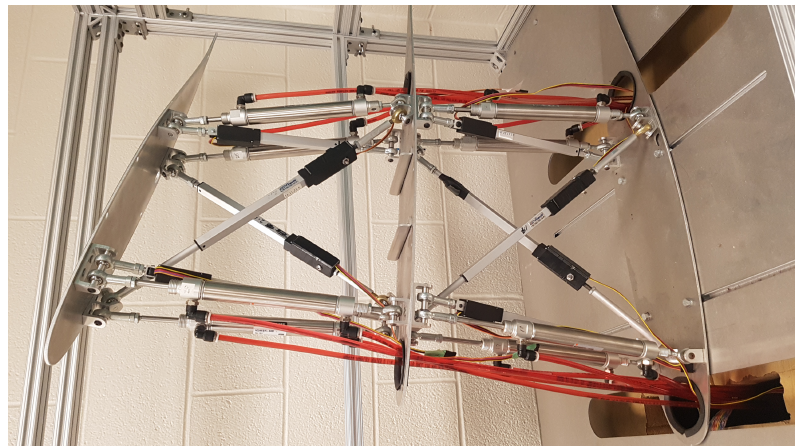
Figure 2. Reconfigurable modular morphing wing, view 2.